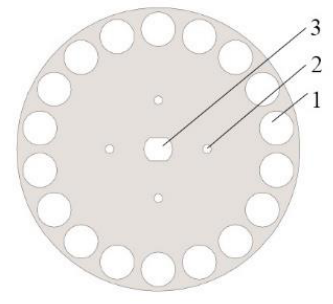
Figure 7. Schematic diagram of the structure of the seed tray body: 1. Seed suction groove mounting hole; 2. Seed stirring device positioning hole; and 3. Drive shaft positioning hole.